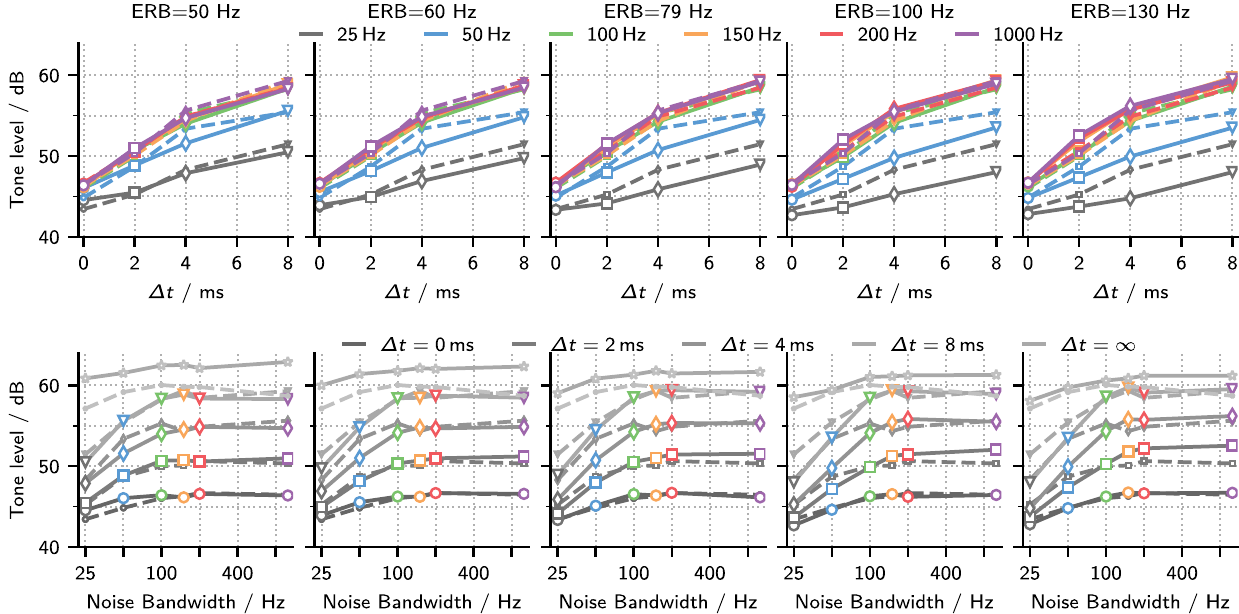
Figure 3. Model predictions (solid lines with symbols) and experimental data (dashed lines). The fi ve columns show predictions obtained with fi ve different fi lter bandwidths. In the top row, thresholds are plotted as in Figure 1. In the bottom row, the same data are plotted as a function of noise bandwidth with different lines representing the different noise ITDs. The symbol color is kept from the bandwidth color-coding in the top row. Data for uncorrelated noise maskers is only shown in the bottom panels in light gray. No error bars are shown for the simulations, because the standard error of the mean was <0.5 dB for all conditions.